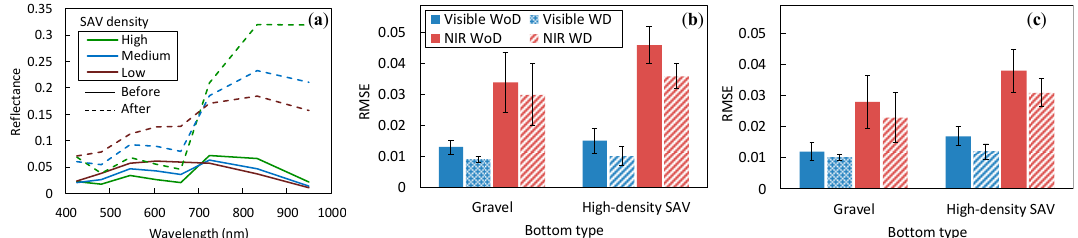
Figure 4. ( a ) Spectra characterized by different SAV densities before and after water-column correction ( R Lab , WV 3 rs vs. r B , WV 3 rs ). RMSEs for the retrieved bottom reflectances (unitless) with (WD) and without (WoD) applying deep-water correction across visible and NIR bands (Equation (7)) using ( b ) R Lab , WV 3 rs and ( c ) R Lab , G rs . Error bars (standard deviation of RMSE _ R ) indicate the effect of variable water depth.